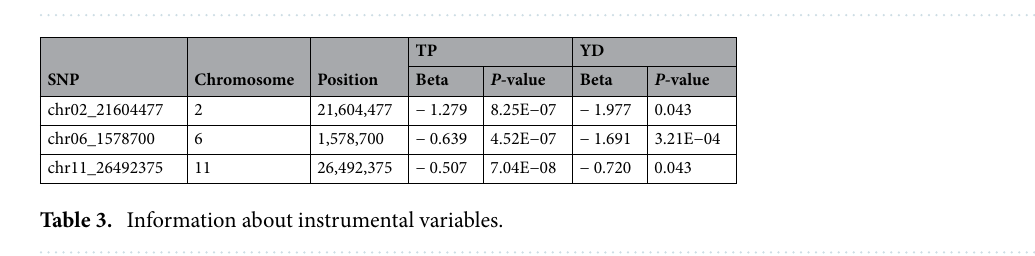
Figure 3. Genetic effect estimates of KGW and YD. Estimates are derived from IVW method of MR analyses. ( a ) Positive effect estimates between KGW and YD. ( b ) Negative effect estimates between KGW and YD.